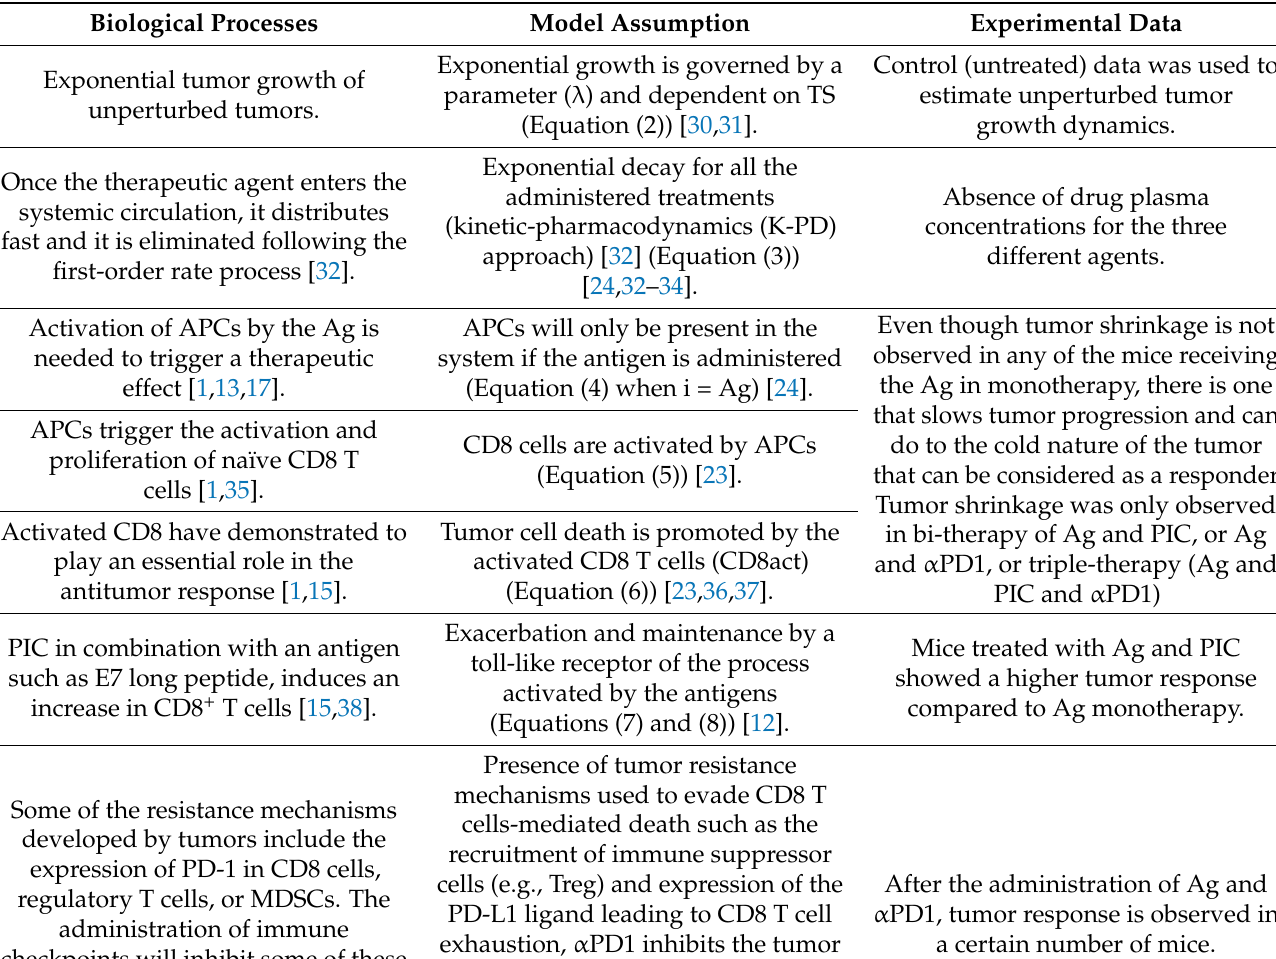
Table 2. Overview of the biological processes considered by the model, together with the different model assumptions and the experimental data supporting those